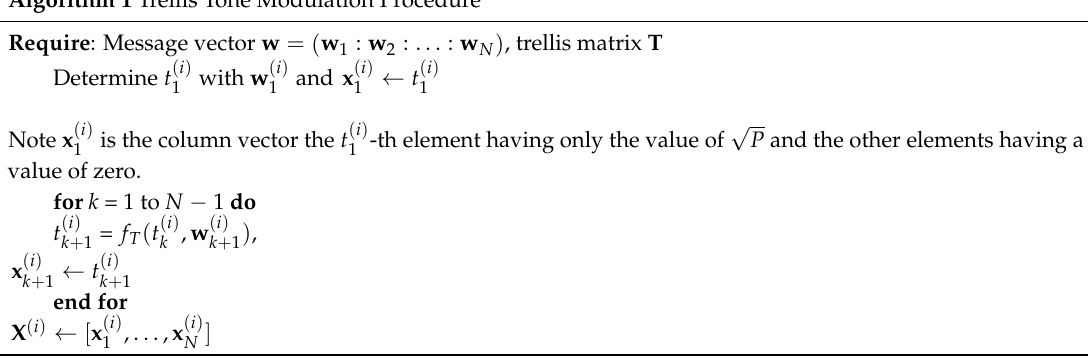
Algorithm 1 Trellis Tone Modulation